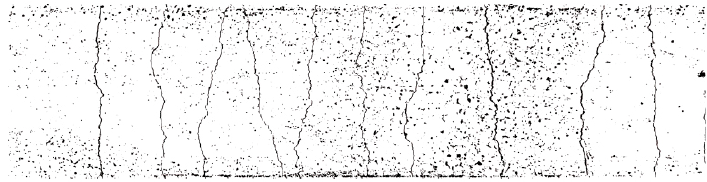
Figure 17. Shot after binary conversion and thresholding.